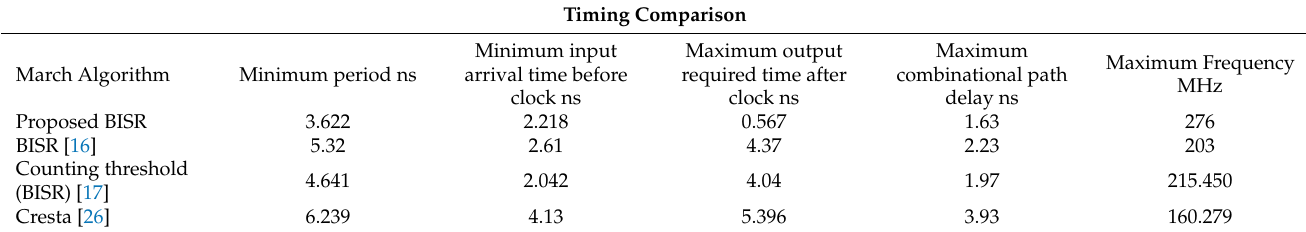
Table 7. Timing/delay and maximum frequency comparison.